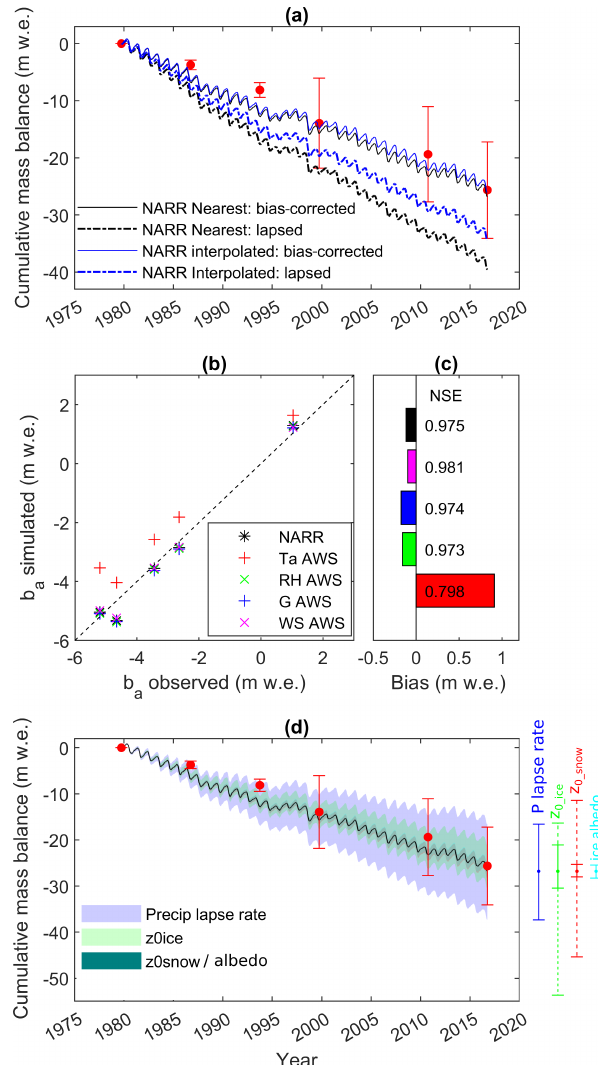
Figure 8. Model sensitivity to NARR forcings and model param- eters uncertainty. (a) Sensitivity to NARR interpolation method (nearest grid cell: black, bilinear interpolation: blue) and bias cor- rection method (continuous line: bias-corrected with AWS, stip- pled line: P NARR and T a , NARR lapse-rate-corrected to the DEM). (b) Sensitivity to NARR forcings: measured vs. simulated point mass balance for glaciological year 2014–2015 after replacing NARR forcings ( T a , NARR , RH NARR , G NARR , WS NARR ) one at a time by AWS observations; (c) corresponding mean error (bias, mw.e., coloured bars) and Nash–Sutcliffe efficiency scores (labels). (d) Sensitivity to model parameter uncertainty. Coloured envelopes represent the cumulative uncertainty; coloured error bars on the right show the effect of parameter uncertainty on the cumulative mass balance in 2016. Error bars for ice (green) and snow (red) roughness lengths correspond to a ± 1mm measurement uncer- tainty; the dotted error bars extend the uncertainty to ± 1 order of